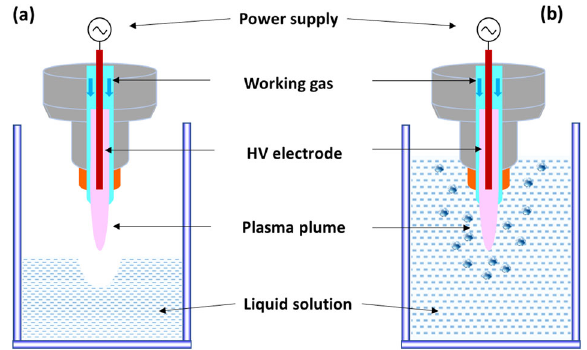
Fig. 1 Generation of plasma-activated water. Discharge over the water surface with indirect contact of the plasma plume with the water surface ( a) and direct contact of the plasma plume with the water surface ( b ).